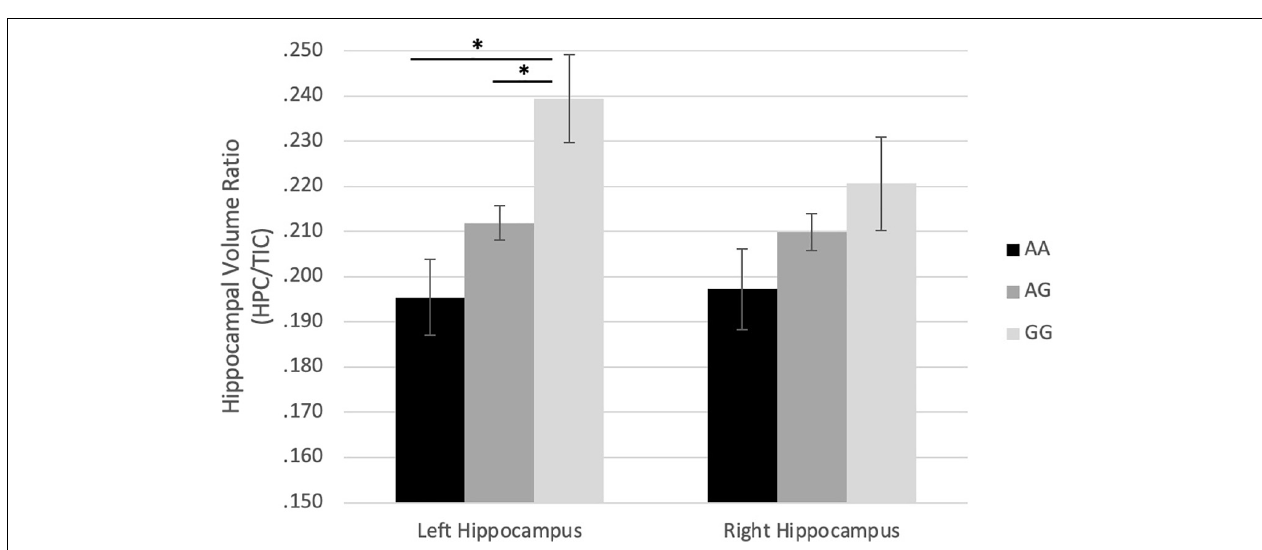
FIGURE 1 | Effect of rs4680 (COMT) genotype on hippocampus/TIC ratio volume in boys. ∗ p < 0.05.